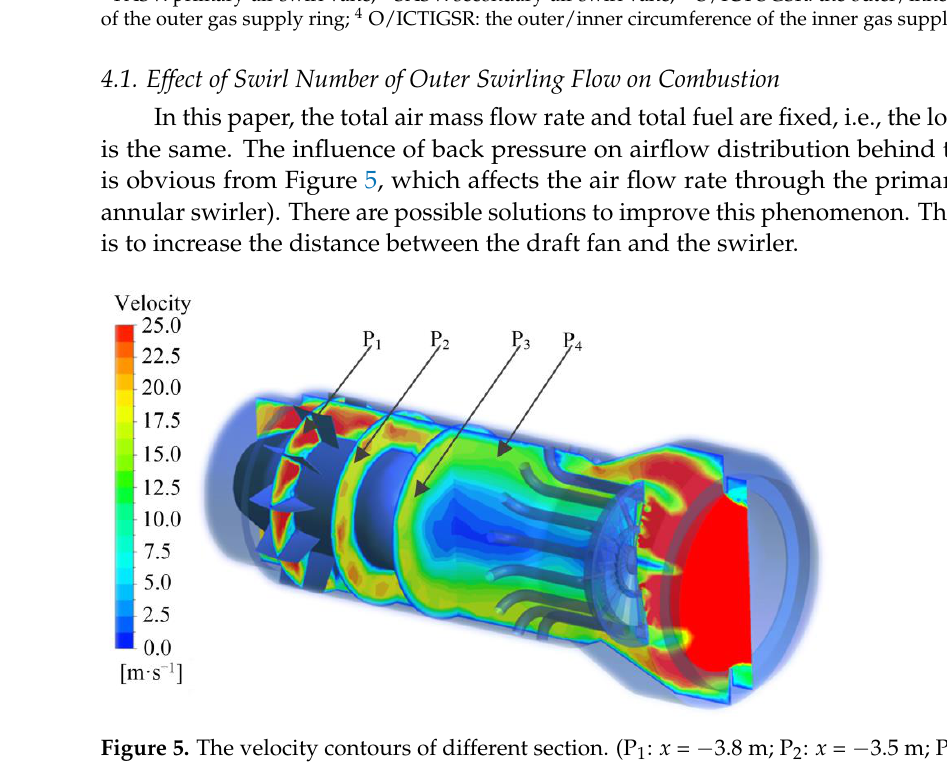
Figure 6. The area-weighted average of methane mass fraction at different section within hood. At this point, it can also be seen that turbulent mixing consumes a large amount of kinetic energy with swirl number equal to 1.29, as shown in Figure 7, so the axial velocity decay is accelerated. Moreover, no central recirculation zone is formed for GC40 and GC30. The air flow rate passing through the swirler is relatively small and rotation inten- sity is weak, so the flow field formed by the vortex breaking downstream of the swirler is not completely diffused and is scattered by the peripheral high-speed jet, resulting in in- stability of the vortex structure. Yet, the formation of small-scale recirculation zones on both sides near the swirler maintains the stability of the flame.